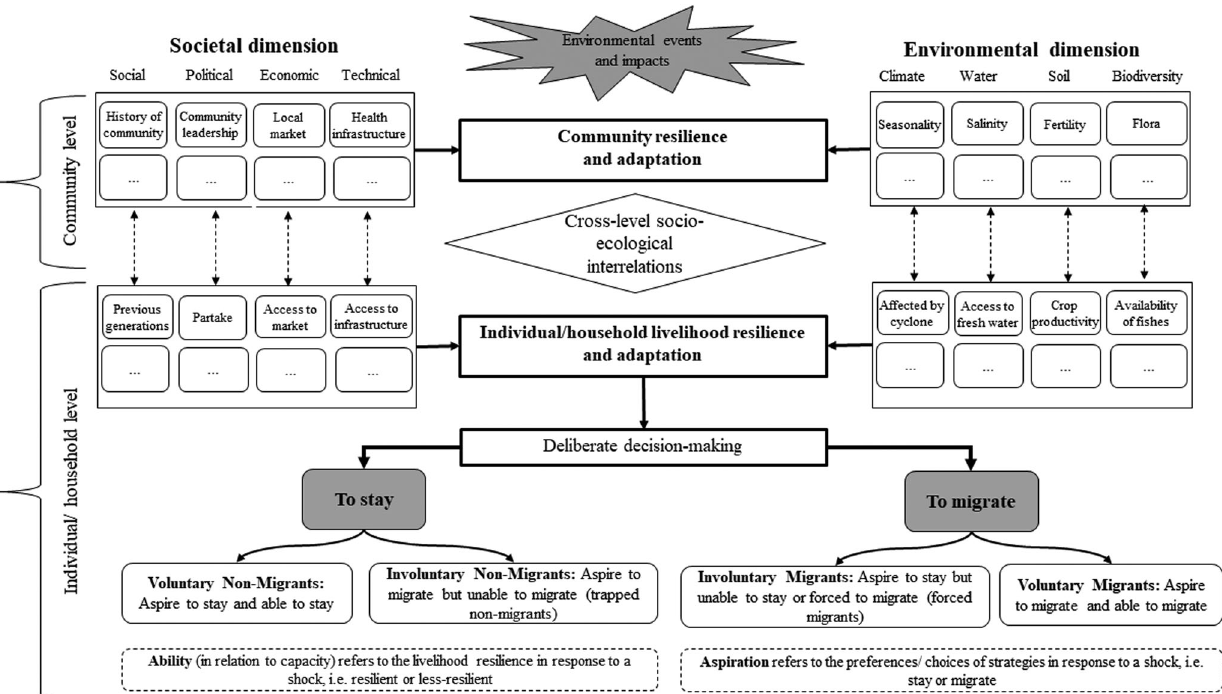
Fig. 1 Analytical framework for the assessment of environmental non-migration decisions considering livelihood resilience. Source: Author ’ s illustration